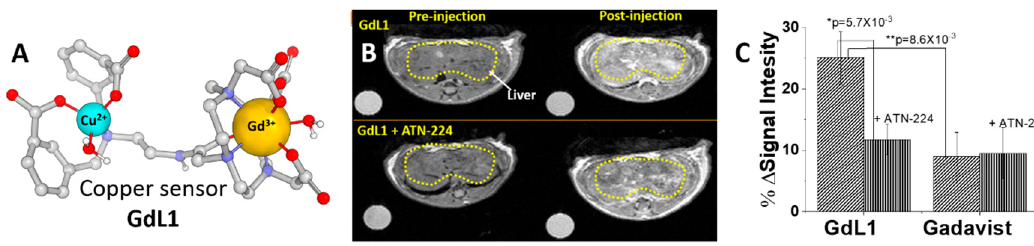
Figure 6. ( A ) Copper-responsive MRI contrast agent, shown chelating a Cu 2+ ion. ( B ) First in vivo demonstration of a copper-responsive MRI contrast agent (Images are from a mouse liver, both with ( bottom ) and without ( top ) pre-treatment with ATN-224, a Cu 2+ chelator. Notice the bright enhancement in the top-left frame after injection of the contrast agent, and the decrease in brightness on the bottom left frame after injection of the contrast agent after ATN-224 treatment, indicating enhancement is due to the presence of copper ions. Since this agent is not expected to cross the cell membrane, copper ions are likely in the extracellular space ( C) quantitative signal intensity changes of the copper-responsive MRI contrast agent (GdL-1), compared to Gadavist, with and without the presence of ATN-224. Adapted from [51].